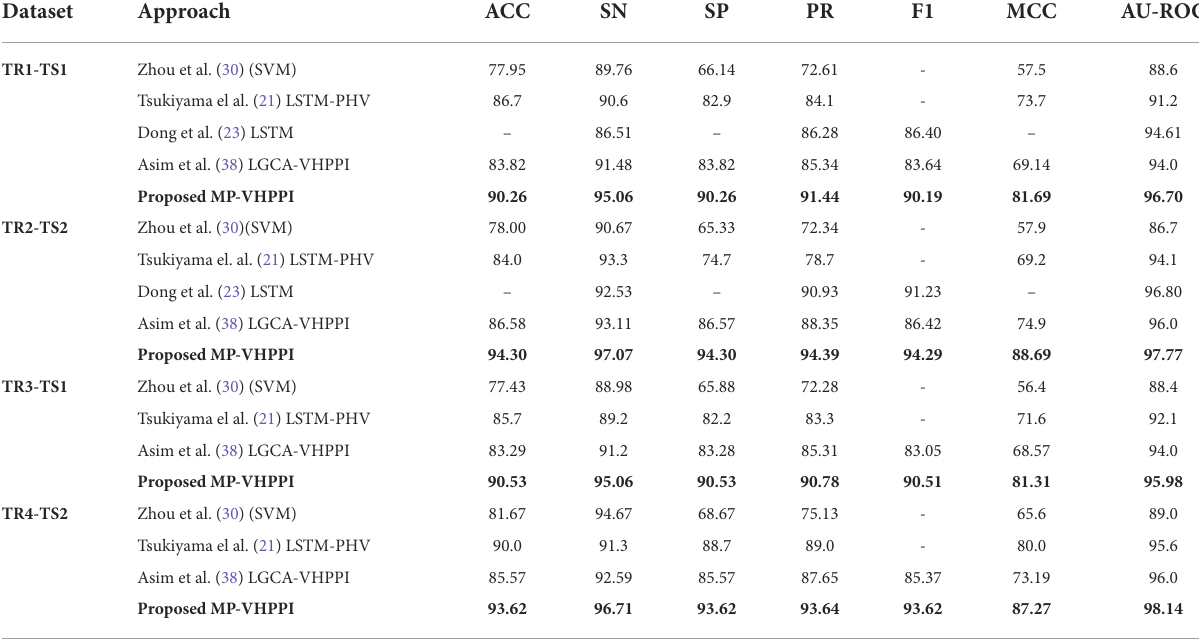
TABLE 6 Performance comparison of the proposed MP-VHPPI with existing virus-Host PPI Predictors over 4 datasets developed by Zhou et al. (30), to assess the applicability of the unseen viruses.